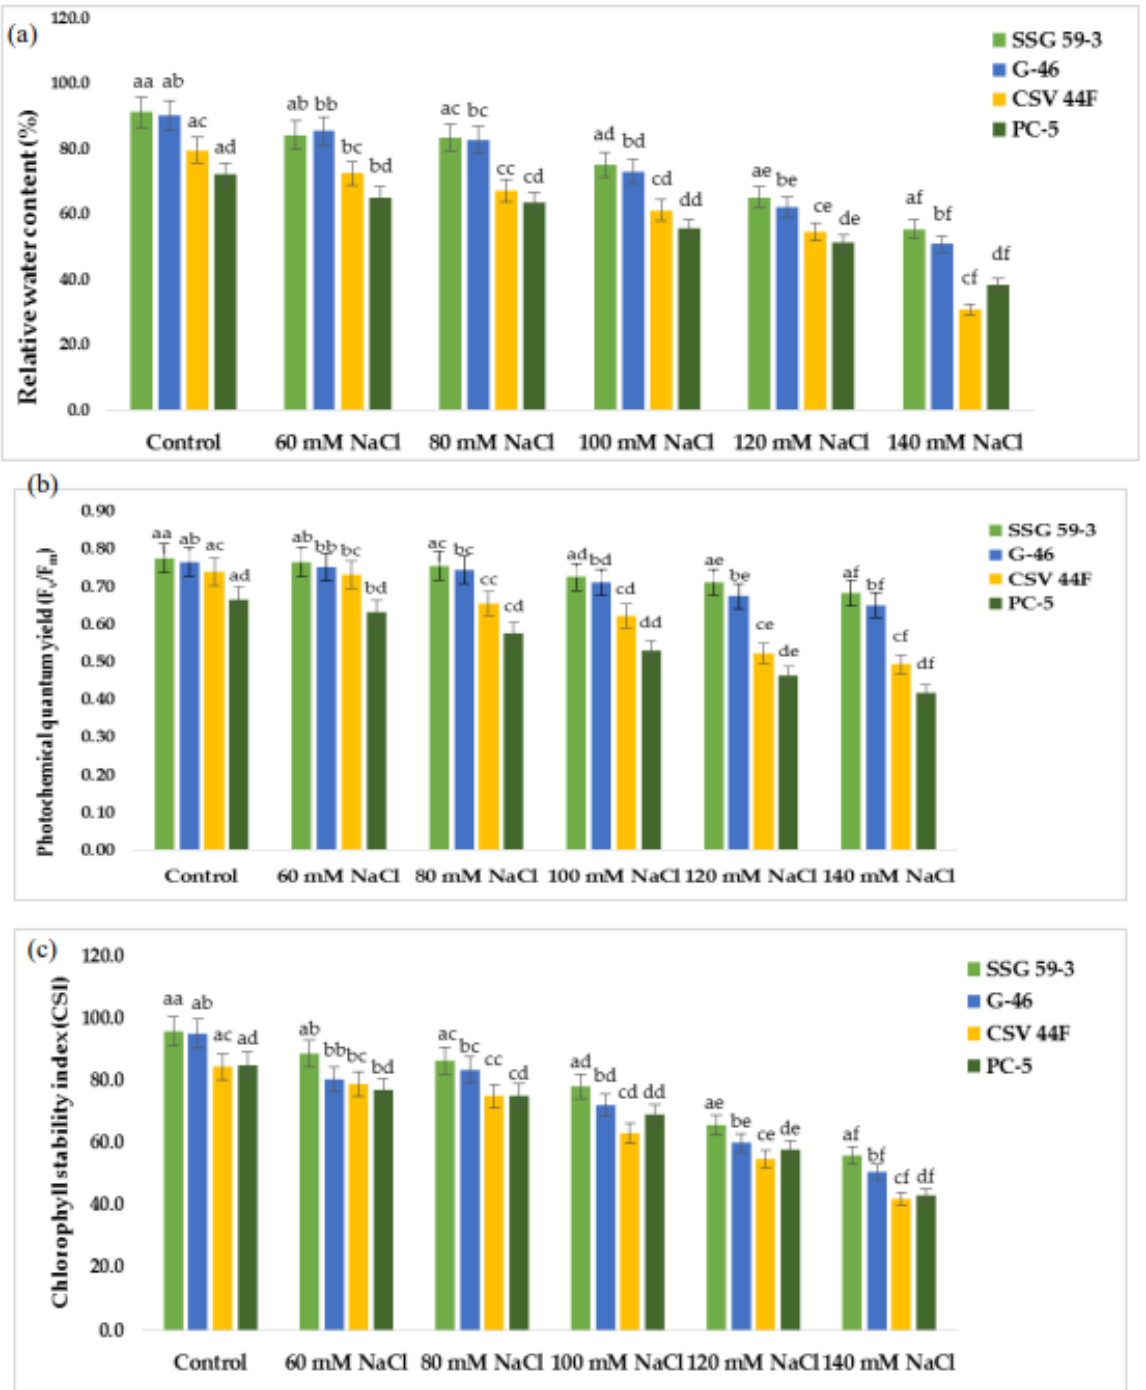
Figure 2. Effect of salt stress on ( a ) relative water content, ( b ) photochemical quantum yield (F v /F m ), and ( c ) chlorophyll stability index of sorghum genotypes. a–f Values with different superscripts in the same row are significantly different at p < 0.05. Table 3. Effect of salinity on germination indices of sorghum seedlings during the early growth stage.